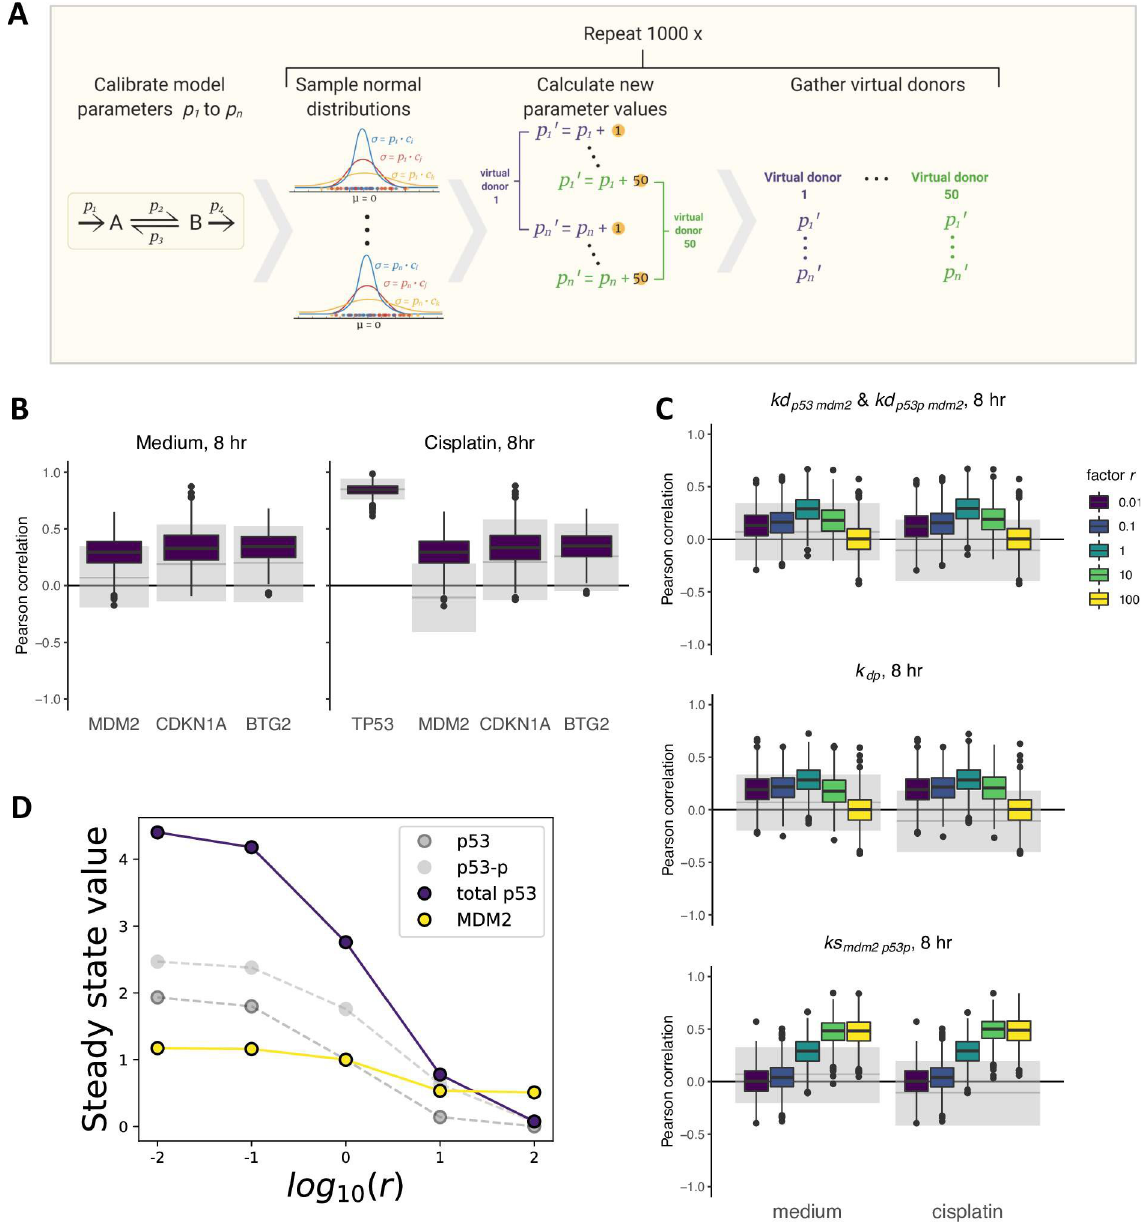
Fig 5. Comparison between correlations for virtual donor samples and PHHs. (A) Graphical explanation of the creation of virtual donor samples. For all fitted parameters P i , we added a value, drawn from a normal distribution with mean 0 and standard deviation p i � c, to the parameter value. We executed this 50 times to generate one set of 50 virtual donor samples and repeated this 1000 times to obtain 1000 sets of 50 virtual donor samples. (B) Correlations between basal TP53 expression and the downstream targets MDM2 , CDKN1A and BTG2 at 8 hours for HepG2-derived virtual samples (colored boxes) and PHHs (grey shaded areas) in basal expression conditions (left) and after 3.3 μ M cisplatin exposure (right) with variability factor c = 0.2 and a small amount of measurement noise, chosen such that the correlation of basal TP53 with itself after cisplatin exposure under variability factor c = 0.2 decreased to the experimentally observed correlations in PHHs. The grey solid lines represent the observed correlations in PHHs and the grey shaded areas represent the 95% confidence interval of correlations found for alternative PHH donor sets acquired with 1000 times bootstrapping. (C) Effect of changes in MDM2 feedback strength (top), dephosphorylation rate (middle) and p53-dependent MDM2 synthesis rate (bottom) on correlation of basal TP53 expression with basal MDM2 expression (medium) or after 3.3 μ M cisplatin exposure (cisplatin) at the 8-hour timepoint and with measurement noise. A value r = 1 implies no adjustment in parameter value with respect to the fitted values, r > 1 implies stronger feedback and r < 1 implies weaker feedback. Grey solid lines and shaded areas are the same as in (B). (D) Adjustments in steady state values of p53 and MDM2 upon changes in factor r.